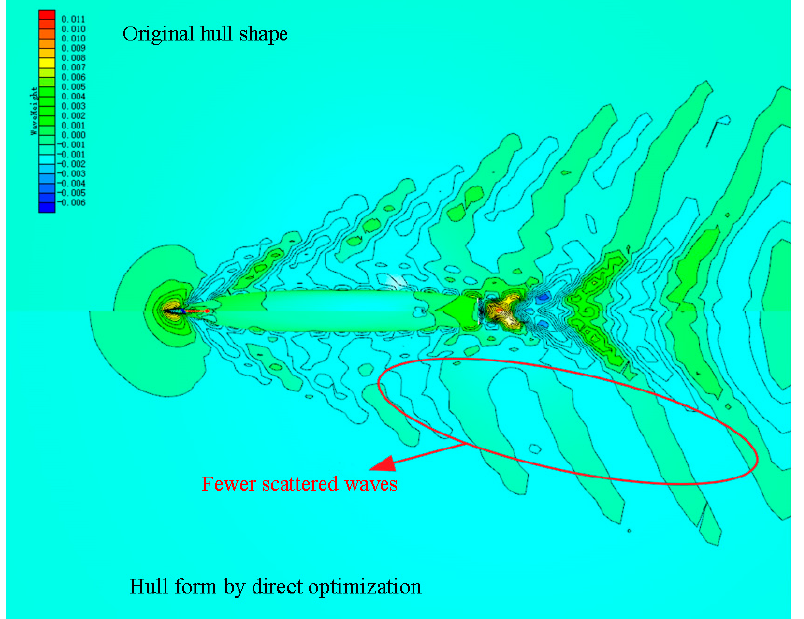
Figure 25. Comparison of wave disturbances of original hull form and hull form obtained by direct optimization.